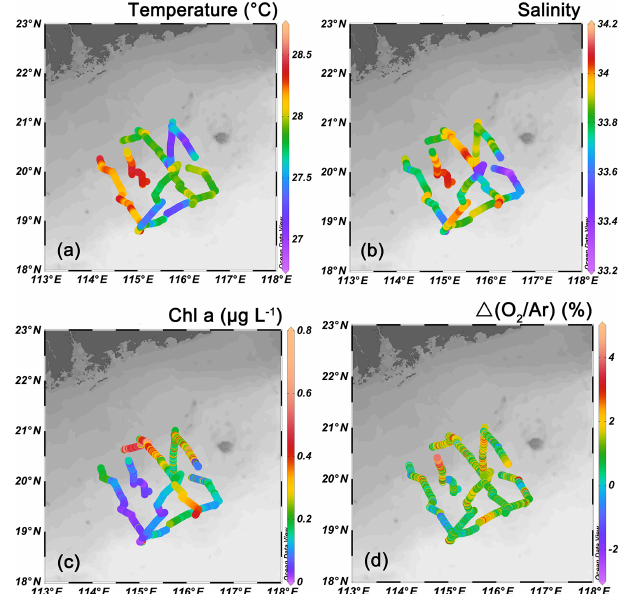
Figure 2. Surface distributions of (a) temperature, (b) salinity, (c) chlorophyll a (Chl a ), and (d) (cid:49) (O 2 / Ar) in October 2014.